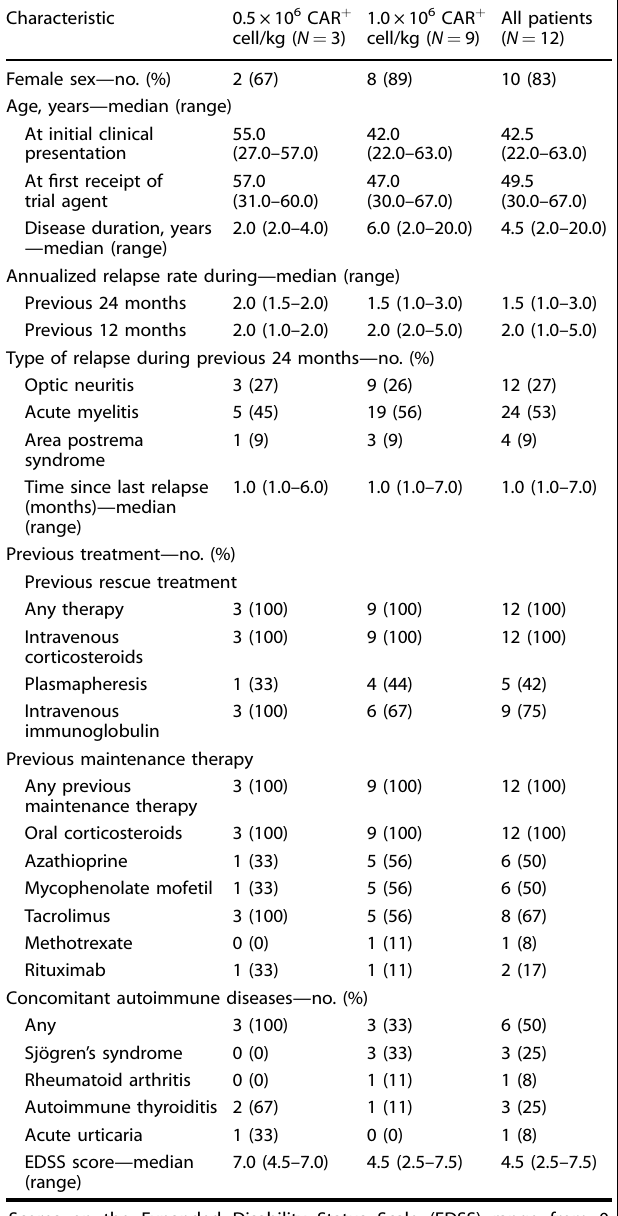
Table 1. Demographic and clinical characteristics of the patients at